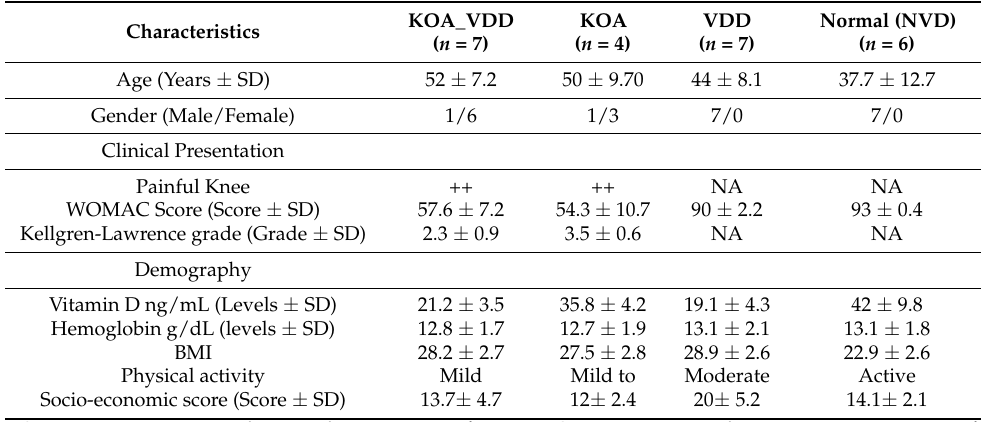
Table 2. Clinico-Demographic